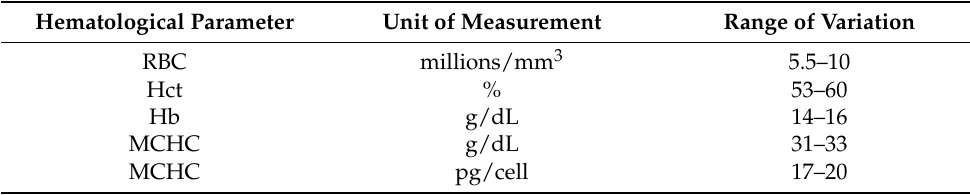
Table 8. Normal values of hematological parameters for Wistar rats [17]. Hematological